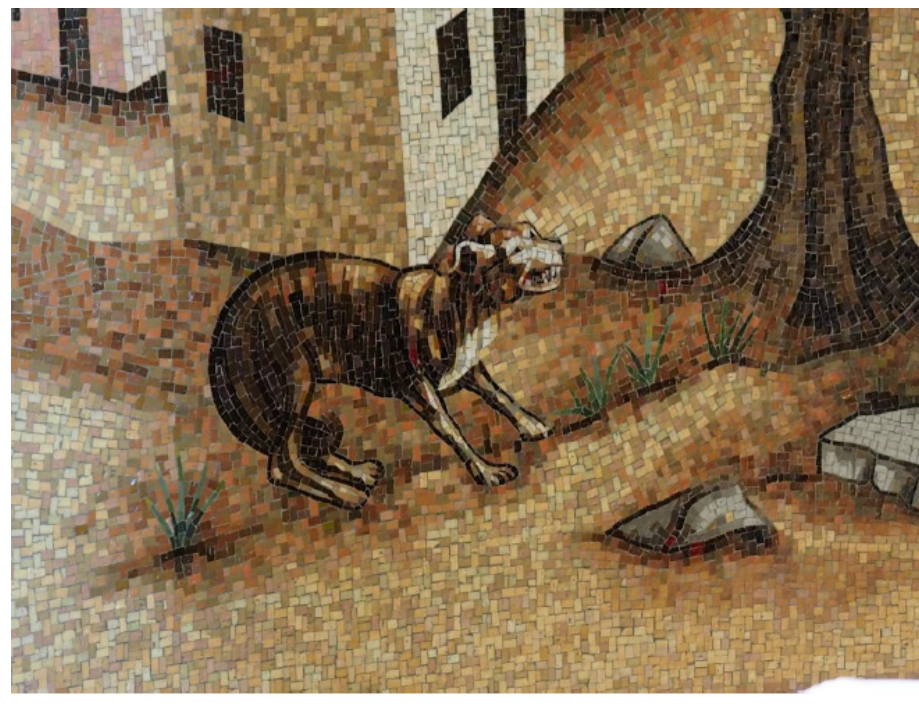
Figure 10. Detail: Barking Dog.